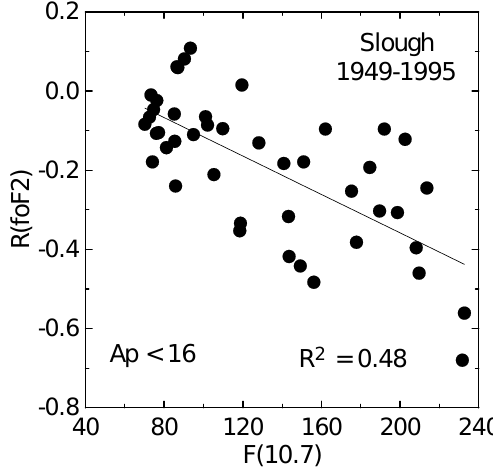
Fig. 3. The R ( fo F2) dependence on the solar activity index F(10.7) for